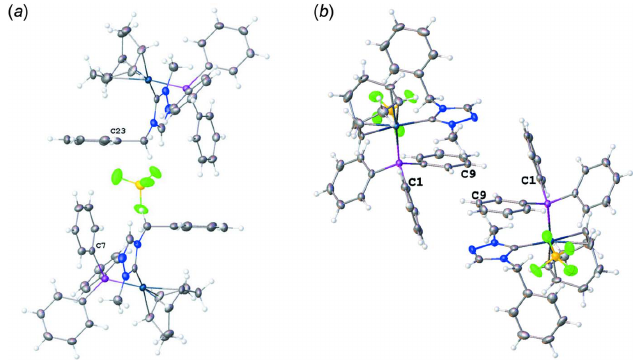
Figure 4 Views of intermolecular interactions of the title compound ( 4 ) showing T- shaped, distorted perpendicular interactions. ( a ) View of the near perpendicular orientation of a phenyl ring (C7) of the triphenyl- phosphane ligand on one moiety and the phenyl ring (C23) attached to the NHC ligand; ( b ) view of distorted perpendicular arranged phenyl rings that are influenced by the C9—H9 (cid:3)(cid:3)(cid:3) (cid:2) [phenyl ring(C1)] inter- molecular